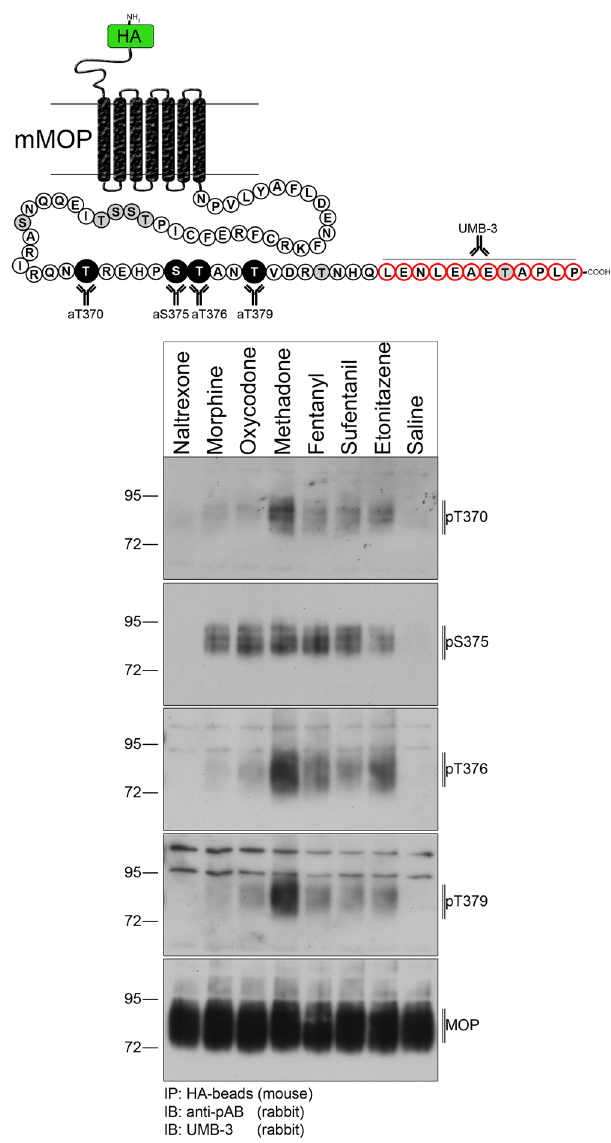
Fig. 3 MOP phosphorylation pattern in vivo. HA-MOP mice were either treated with different MOP agonists, naltrexone, or saline. Western blots of brain lysates immunoblotted with anti-pThr370 ( fi rst panel), anti-pS375 (second panel), anti-pThr376 (third panel), or anti-pThr379 (fourth panel) antibodies. Blots were stripped and reprobed with a UMB-3 antibody to control for equal loading. Positions of molecular mass markers are indicated on the left (in kDa). Blots are representative of four independent